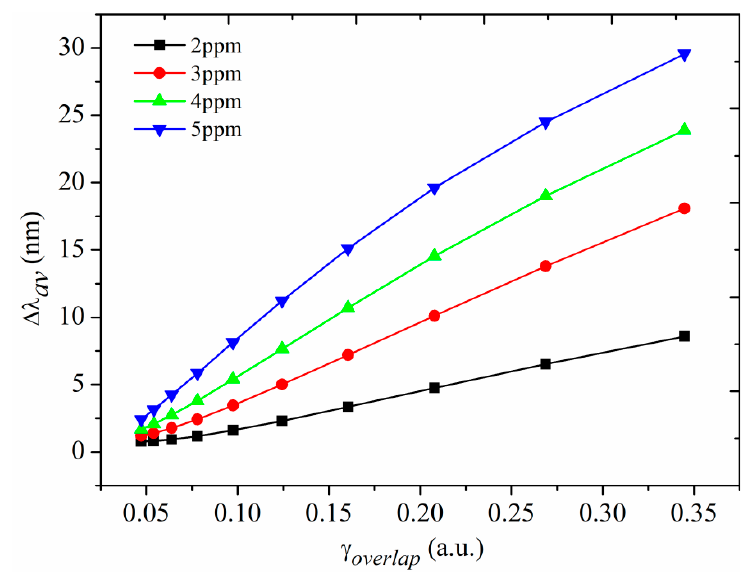
Figure 10. The red shift of average wavelength as a function of the overlap coefficients.